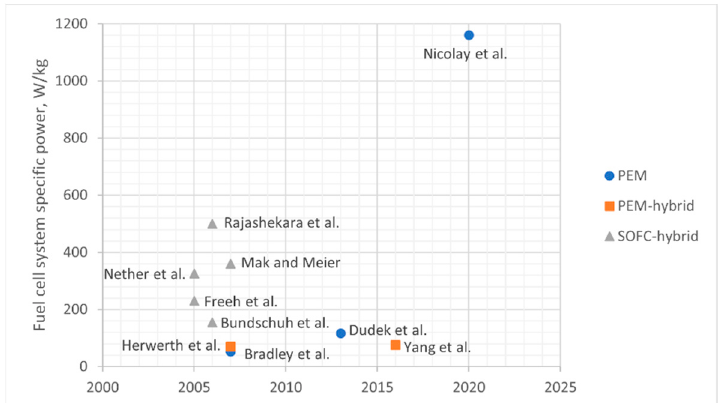
Figure 15. Specific power of fuel cells systems for aircraft applications.